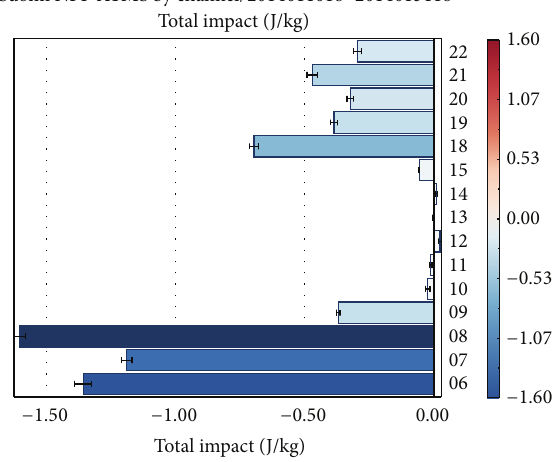
Figure 14: FSO statistics separated out by ATMS channel (January 2014).